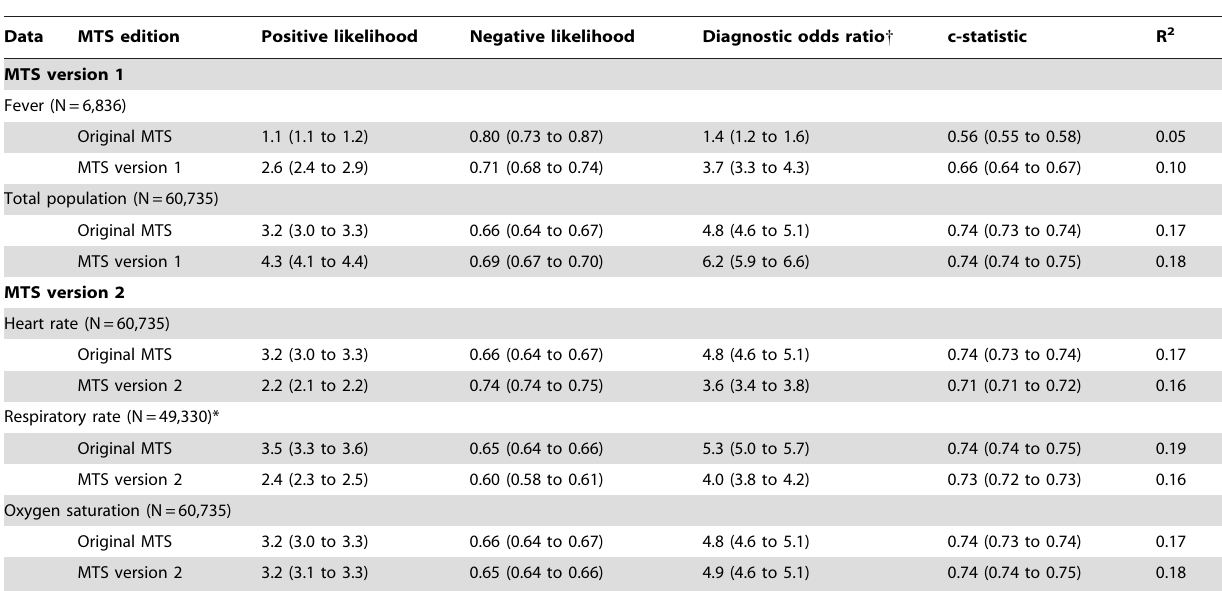
Table 3. Performance of the original MTS, MTS version 1, and MTS version 2.